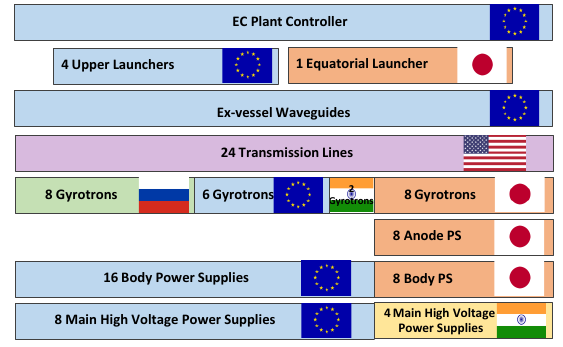
Fig. 2. EC system procurement strategy.